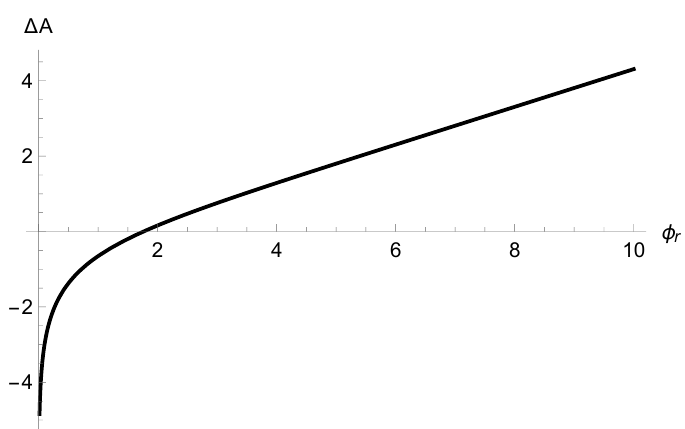
˜ A between the RT candidates shown in figure 7, ) . We have fixed z = 2 . For sufficiently large φ 0 h = 0 0